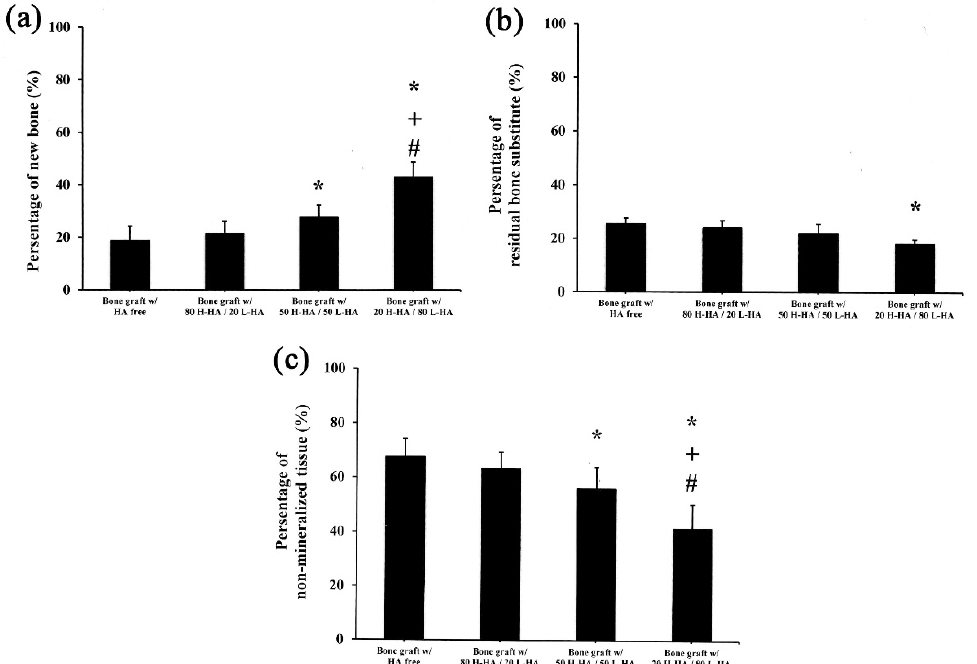
Figure 5. Statistical analysis of micro-CT quantification of ( a ) new bone formation, ( b ) residual bone substitute and ( c ) non-mineralized tissue. Data are expressed as mean ± standard deviation. The symbol * denotes a significant difference from the “bone graft with HA free” group, + denotes a significant difference from the “bone graft with 80 H-HA/20 L-HA” group, # denotes a significant difference from the “bone graft with 50 H-HA/50 L-HA” group. Significance ( p < 0.05) was determined using the post hoc Duncan test after one-way ANOVA.